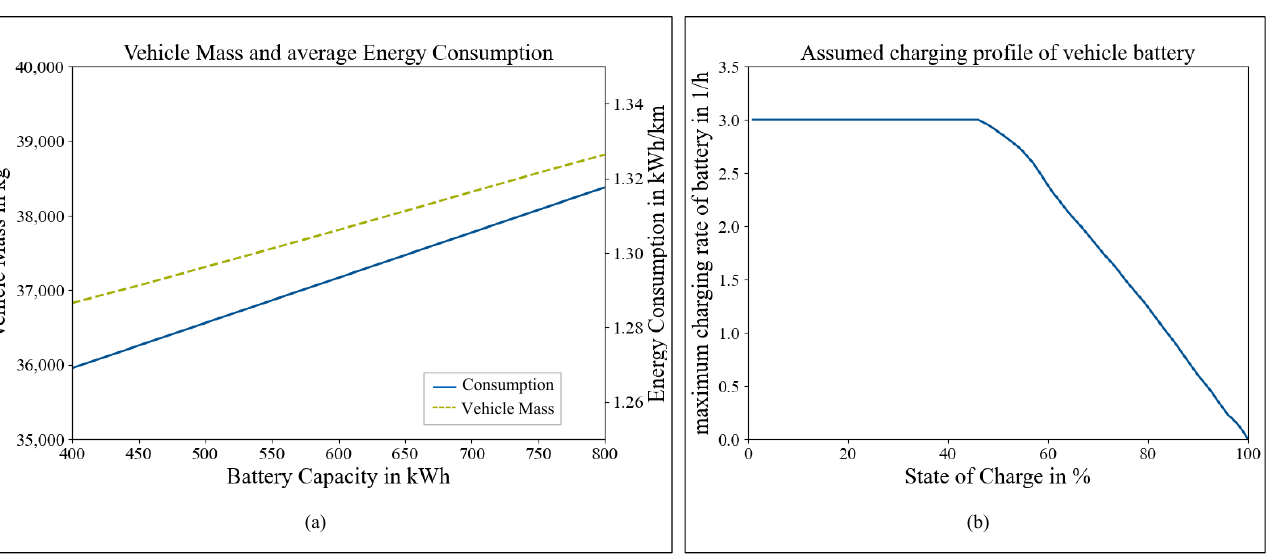
Figure 3. ( a ) Vehicle energy consumption and total vehicle mass over battery capacity. ( b ) Used maximum charging rate over the SoC according to [30], with degradation at a 50% SoC.